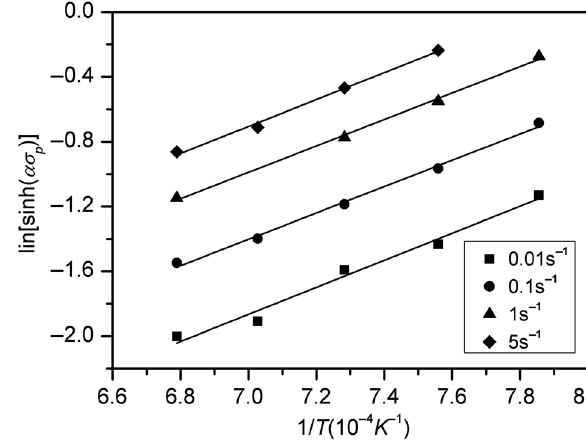
Figure 3: Relationship between SSE and α . Figure 5: Relationships between ln[sinh( ασ